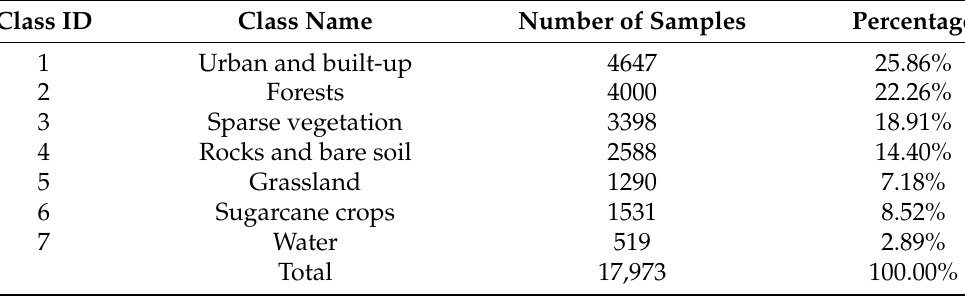
Table 1. Class distribution of the Reunion Island dataset.